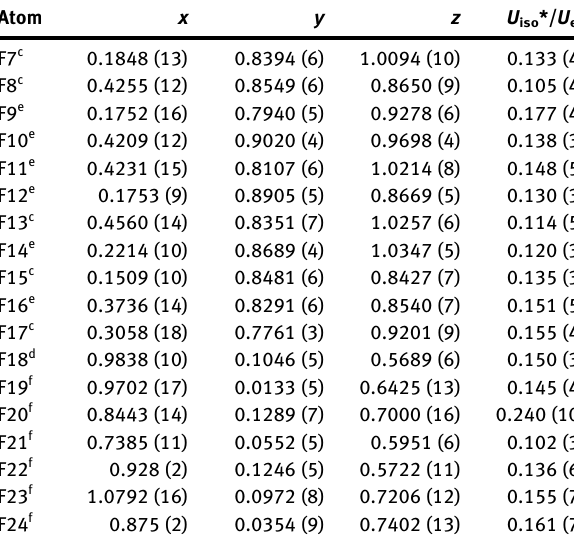
Table  : Fractional atomic coordinates and isotropic or equivalent isotropic displacement parameters (Å 